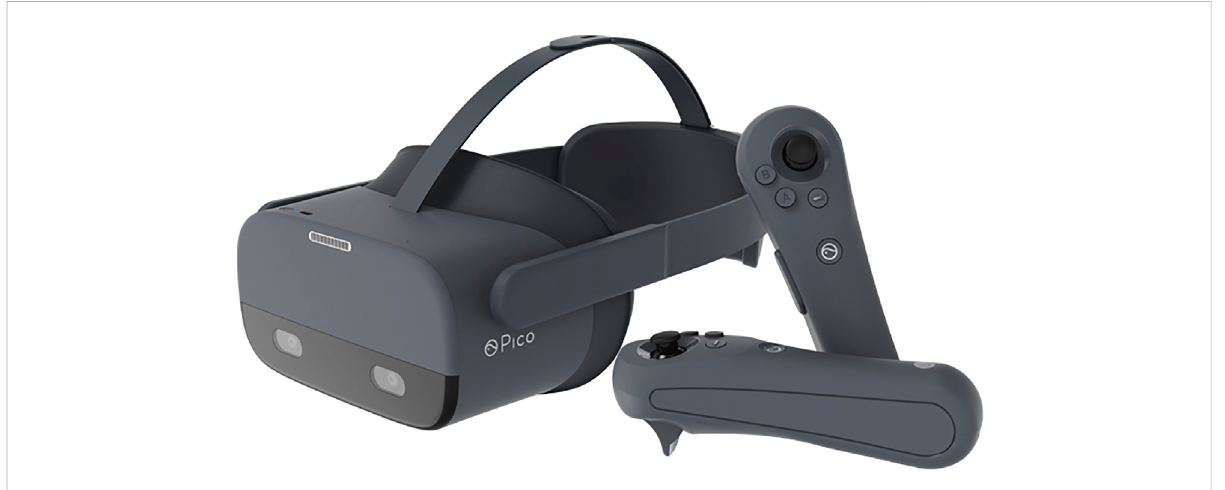
FIGURE 3 Pico Neo two Eye headset used by participants to experience virtual reality module. Image shared with permission from Tobii